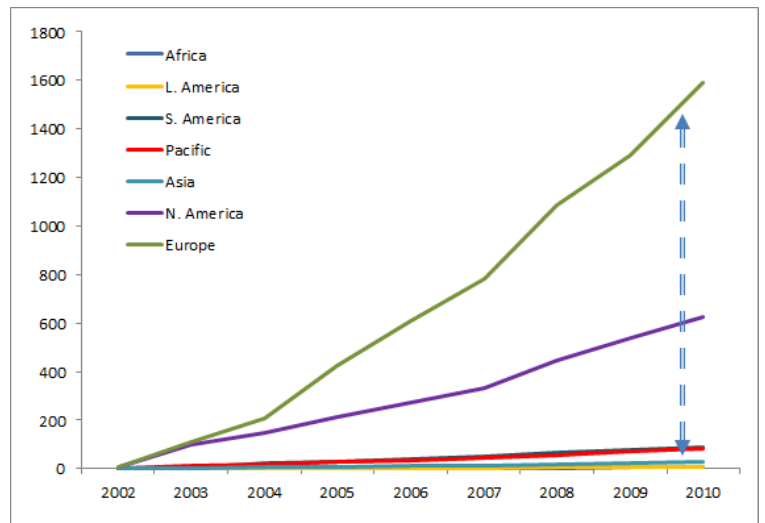
Figure 6. Number of OA journals by continent [62].